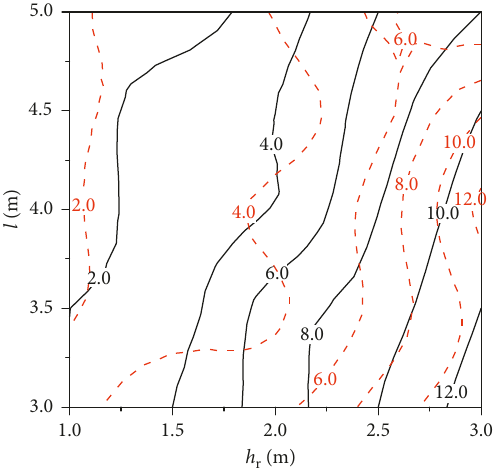
Figure 13: Contour map of the ultimate bearing